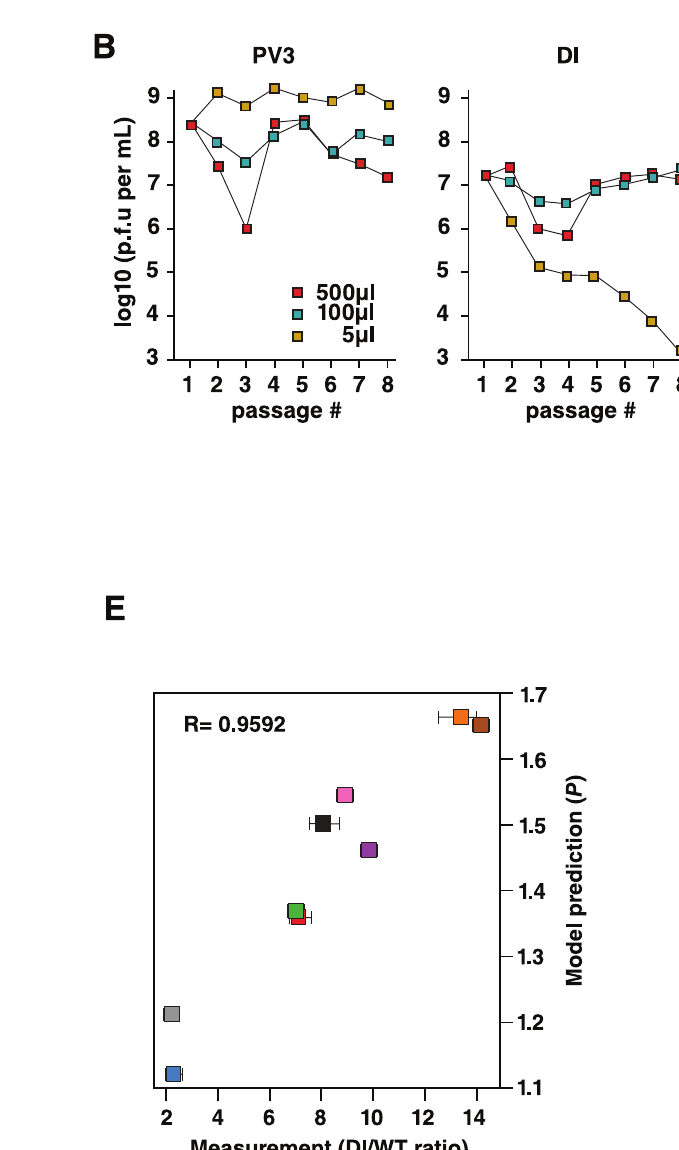
PLOS Pathogens| https://doi.org/10.1371/journal.ppat.1009277 September 27,